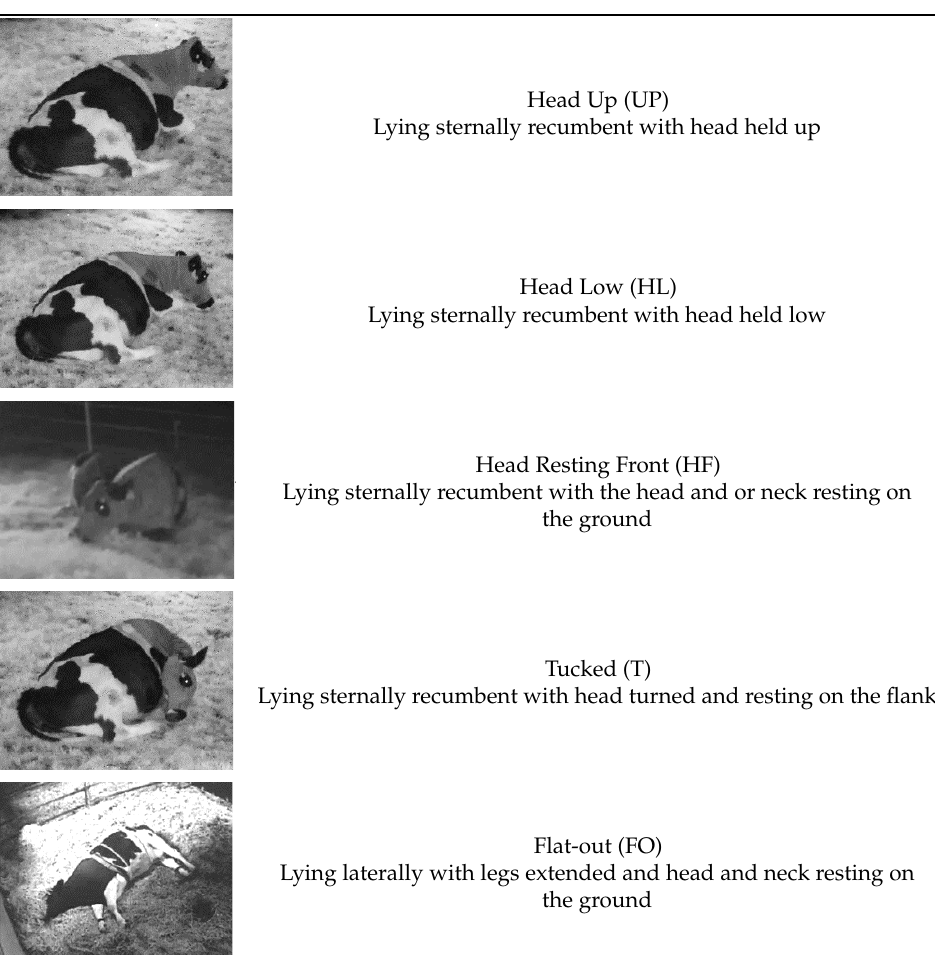
Table 1. Behavioural ethogram for scoring lying postures in dairy cows, including head